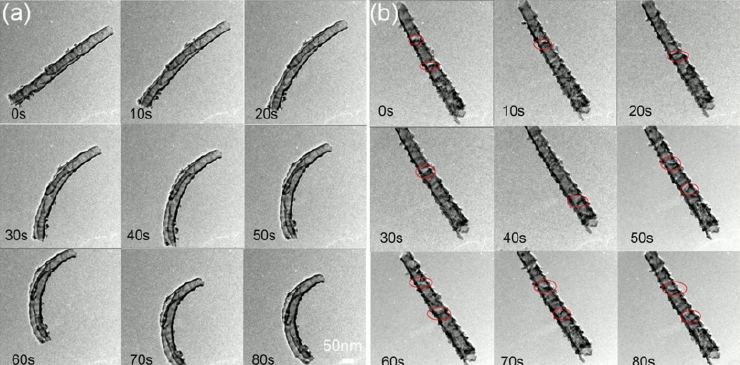
Figure 7. TEM images acquired at 10 s intervals during in situ 46 keV Au − irradiation up to a total irradiation time of 80 s of ( a ) amorphous and ( b ) anatase TiO 2 nanotubes. Reproduced with permission from ref. [44].